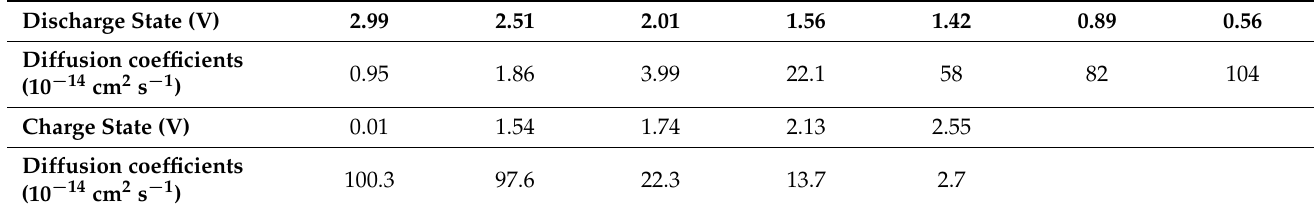
Table 2. The value of diffusion coefficients at different coefficients about